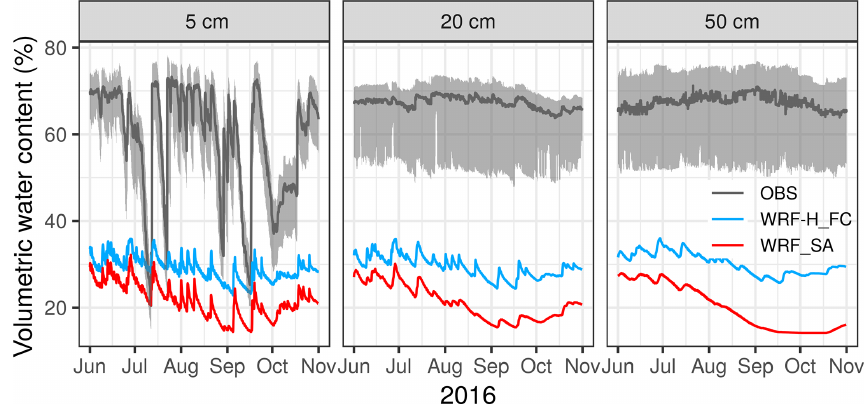
Figure 11. Volumetric water content at the DE-Fen site for three different depths. Gray ribbon: range between first and third quartile of SoilNet observations; gray line: median of SoilNet